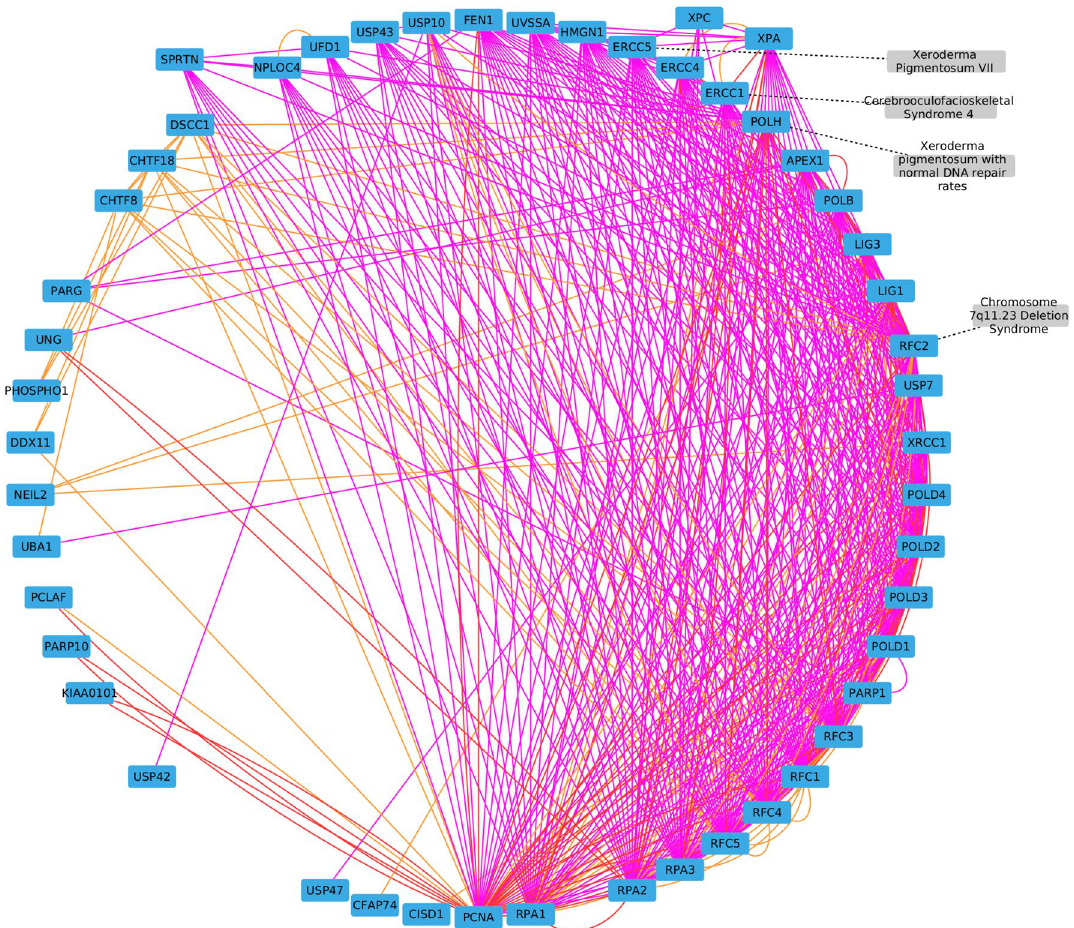
Figure 6. Cluster containing the Xeroderma pigmentosum VII disease node. Gene-Gene edges from the molecular multiplex network are represented in pink (Reactome pathways), red (protein-protein interactions) and orange (molecular complexes). Gene-Disease bipartite interactions are represented with black dashed